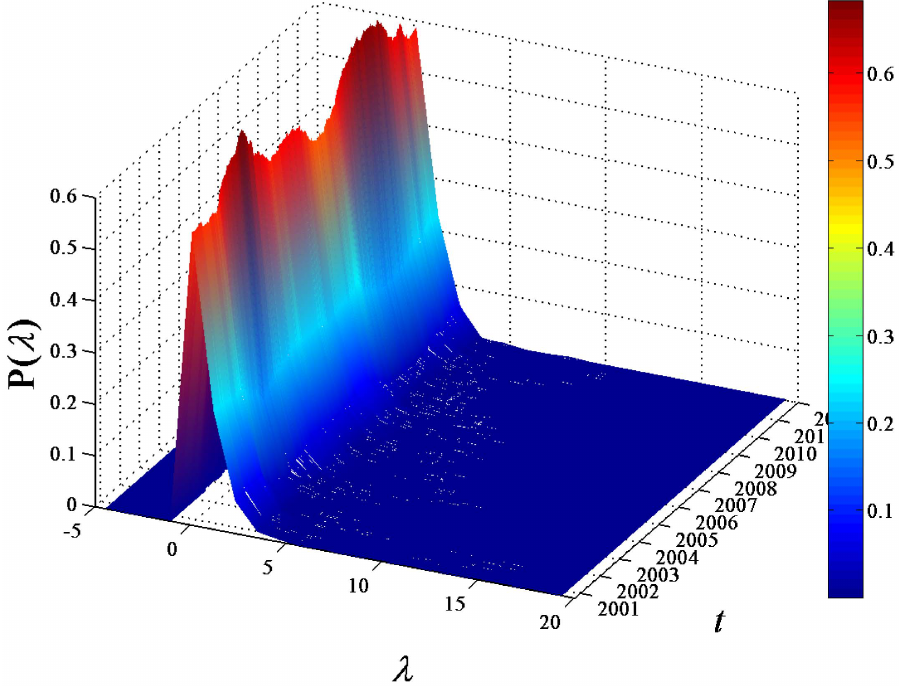
Figure 3. Dynamics of eigenvalue distribution. Probability density function (PDF) P ( l ) of the eigenvalues obtained from the correlation matrix of the return series of 367 A-Share stocks evolved with the time t .